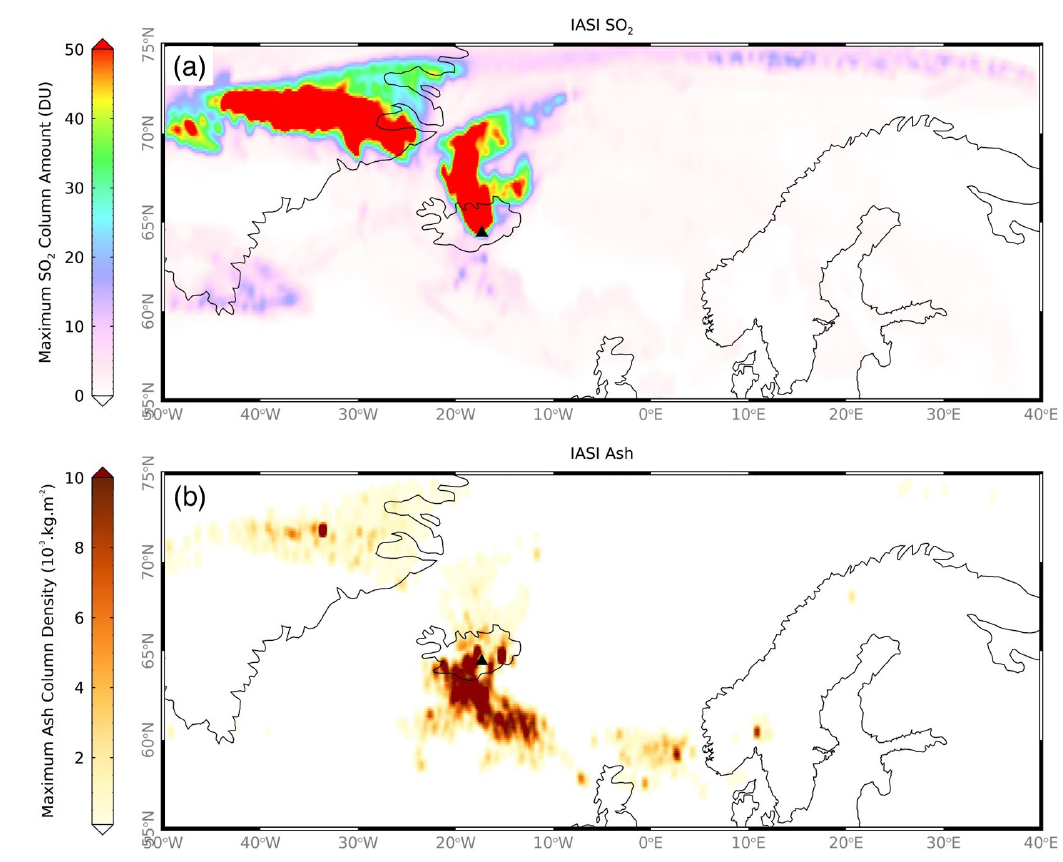
Figure 1. ( a ) Maximum observed SO 2 column amount and ( b ) Maximum observed ash column loading for the period between 21 and 26 May 2011 inclusive. The IASI retrieval outputs were gridded for each orbit and, similar to Moxnes et al. (2014), the maximum value observed during all the overpasses in the given period is